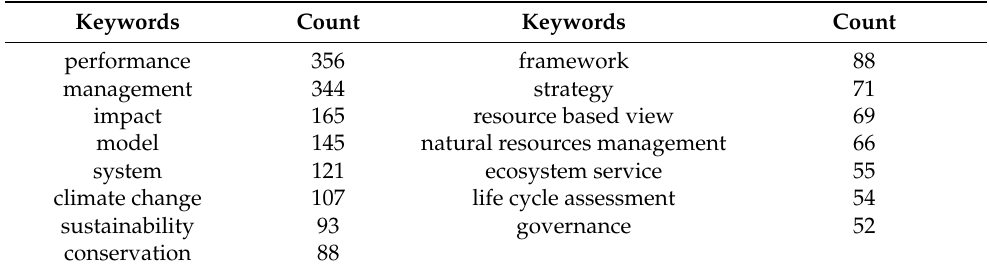
Table 1. High-frequency keywords of research on performance management of natural resources from 1990 to 2021 (frequency >